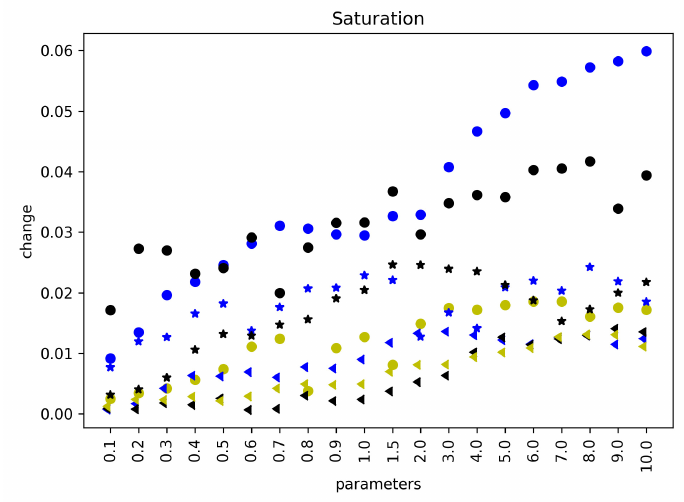
Figure 8. Impacts comparison of Brightness, Contrast and Saturation. The impacts of Brightness, Contrast and Saturation on improving the classification performance on Γ PAP , Γ CCZ , and Γ CSD are plotted in the figure.